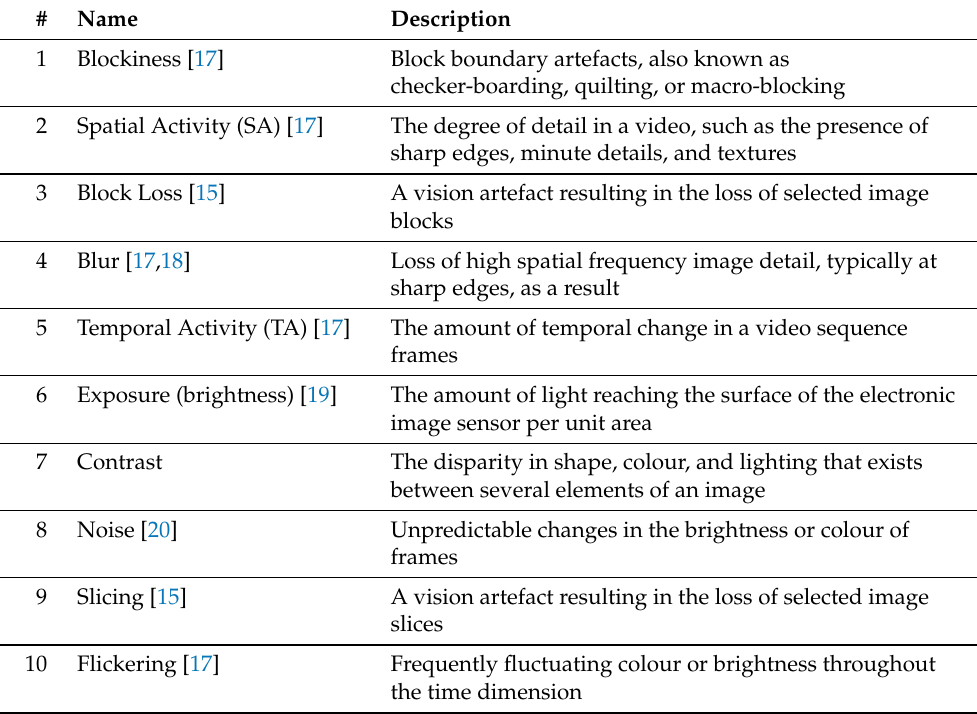
Table 2. The list of video indicators which are used in the experiment (based on: